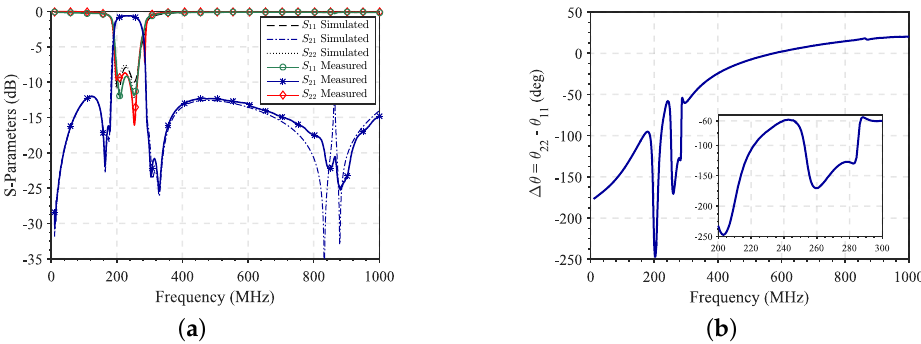
Figure 16. ( a ) Measured and simulated filter transmission response, and input/output reflection coef- ficient. ( b ) Difference between input and output measured reflection coefficient phase ∆ θ = θ 22 − θ 11 . The simulation was carried out with ANSYS ® Electronics Desktop 2021 R1. The manufactured filter was characterized with the network analyzer N5242B